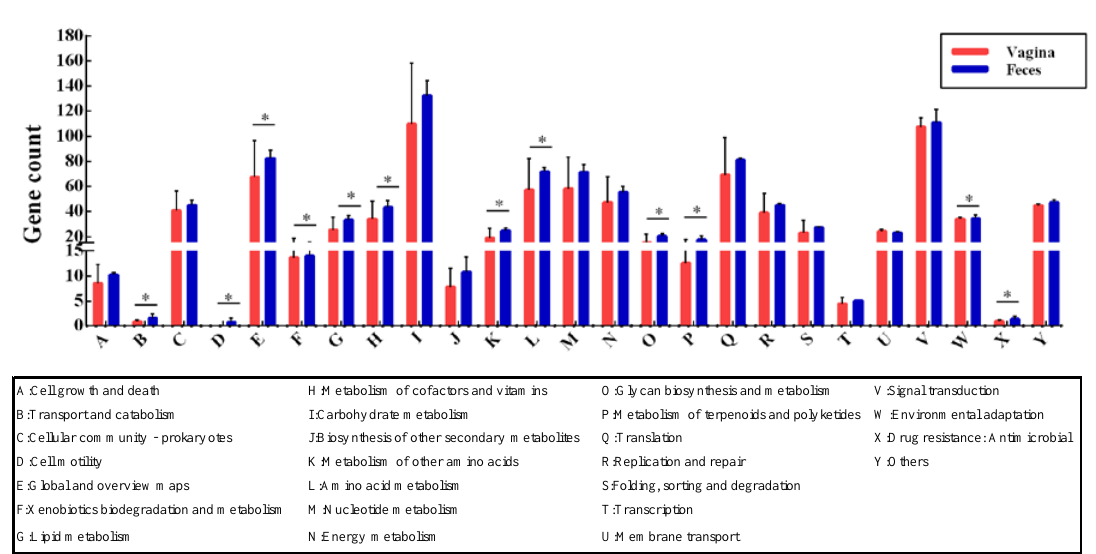
Figure 5. Annotation for genes of L. crispatus isolated from vagina and gut using the KEGG database. * p <